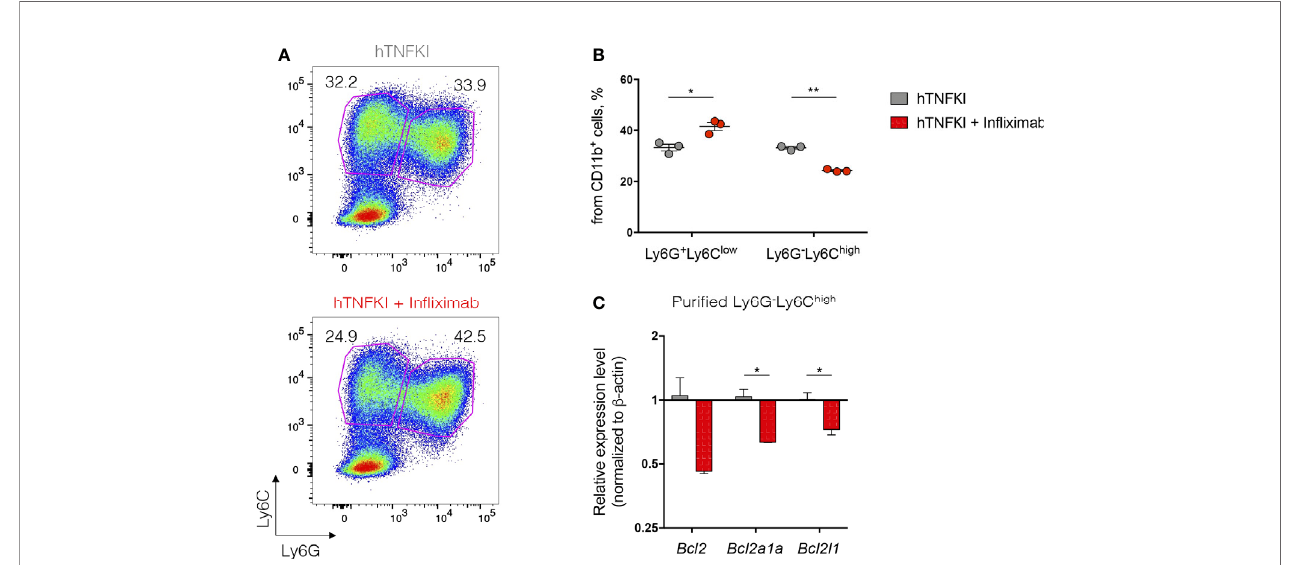
FIGURE 2 | TNF inhibition affects immature myeloid cell development in vitro . Bone marrow cells were isolated from femurs of hTNFKI mice and cultured for 5 days in RPMI 1640 medium supplemented with L-Glutamine (2 mM), penicillin (100U/ml), streptomycin (100 m g/ml), HEPES (10 mM), b -mercaptoethanol (50 m M), 10% FBS, GM-CSF (20 ng/ml) and IL-4 (10 ng/ml). In fl iximab was added in the fi nal concentration of 100 ng/ml. After 5 days in culture cells were stained with Fixable Viability Dye, CD11b (M1/70), Ly6C (HK1.4), Ly6G (RB6-8C5) and acquired with BD FACSCanto II fl ow cytometer. Data were analyzed using FlowJo software. (A) Representative FACS plots of Ly6G + Ly6C low and Ly6G - Ly6C high cells gated on VD - CD11b + cells. (B) Frequencies of Ly6G + Ly6C low and Ly6G - Ly6C high cells gated on VD - CD11b + cells. (C) Ly6G - Ly6C high cells were puri fi ed using Myeloid-Derived Suppressor Cell Isolation Kit (Miltenyi Biotec) according to the manufacturer ’ s protocol. RNA was isolated from puri fi ed cells using TRIzol Reagent (Invitrogen) according to the manufacturer ’ s instructions. RNA (1 m g) was treated with DNase I and reverse transcribed to cDNA with M-MuLV reverse transcriptase (RevertAid fi rst strand cDNA synthesis kit, Thermo Scienti fi c). Real-time quantitative PCR was performed using qPCRmix-HS SYBR+LowROX (Evrogen) and the following primer set: Actb , Forward: CTCCTGAGCGCAAGTACTCTGTG, Reverse: TAAAACGCAGCTCAGTAACAGTCC, Bcl2 , Forward: GAGTTCGGTGGGGTCATGTG, Reverse: TATAGTTCCACAAAGGCATCCCAG, Bcl2a1a , Forward: GGCAGAATGGAGGTTGGGAAG, Reverse: ATTCTCGTGGGAGCCAAGGT, Bcl2l1 , Forward: AGAGAGGCAGGCGATGAGTT, Reverse: TCCACAAAAGTGTCCCAGCC. Reactions were run using the following program on the Applied Biosystems 7500: 95°C for 10 min, 40 cycles of 95°C for 15 sec, 61°C for 30 sec and 72°C for 20 sec. Each point in a diagram represents a single mouse; mean ± SEM. * P < 0,05; ** P < 0,01. Two-tailed unpaired Student ’ s t-test was